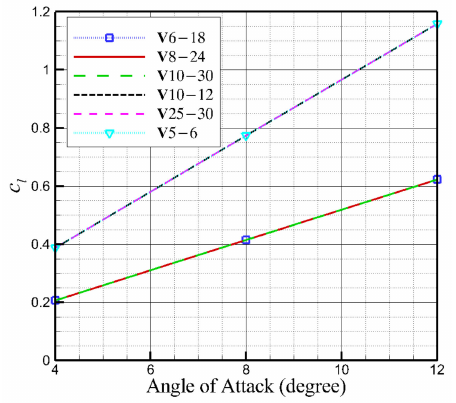
Figure 20. Comparisons of lift coefficient under different jet and freestream velocities.